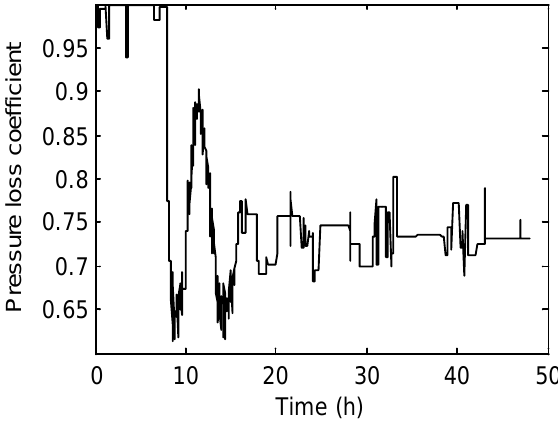
Figure 3. Fault parameter in the base case of fault 7.